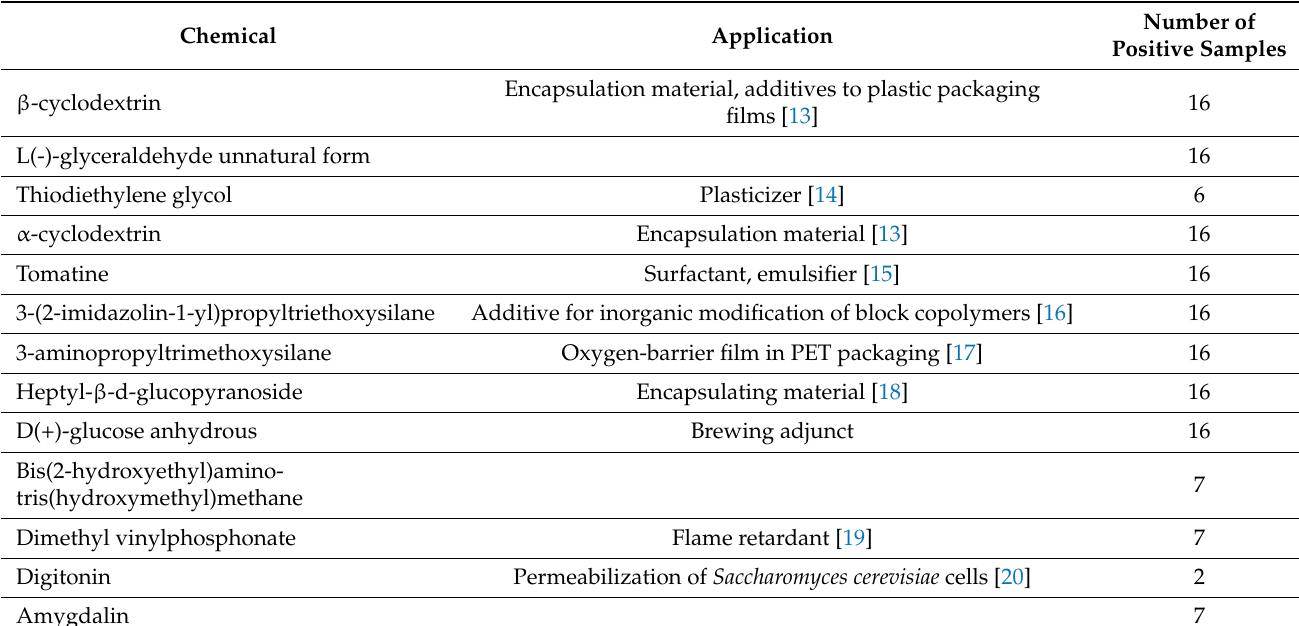
Table 1. List of detected